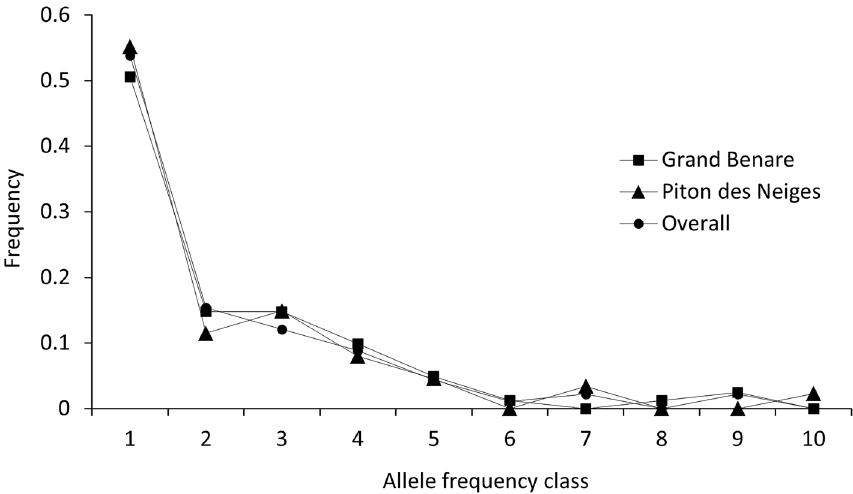
Figure 5. L-shaped mode shift highlighting allele frequency distributions and the absence of bottleneck in two breeding colonies and the overall sampled population of Barau’s Petrels ( Pterodroma baraui ). Population bottlenecks cause a characteristic mode-shift distortion in the distribution of allele frequencies. Bottlenecks cause alleles at low frequency (< 0.1) to become less abundant than alleles in one or more intermediate allele